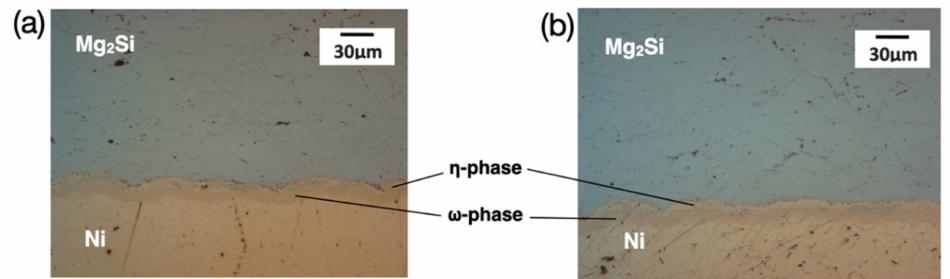
Figure 8. Optical micrograph observations of the interfaces between the Ni electrodes and the Mg 2 Si matrix: ( a ) as-sintered condition for the Ni/Mg 2 Si interface formed by monobloc sintering, ( b ) thermally annealed condition for 5000 h at 873 K. The observation surface of the annealed sample was polished to obtain the observable surface by removing surface